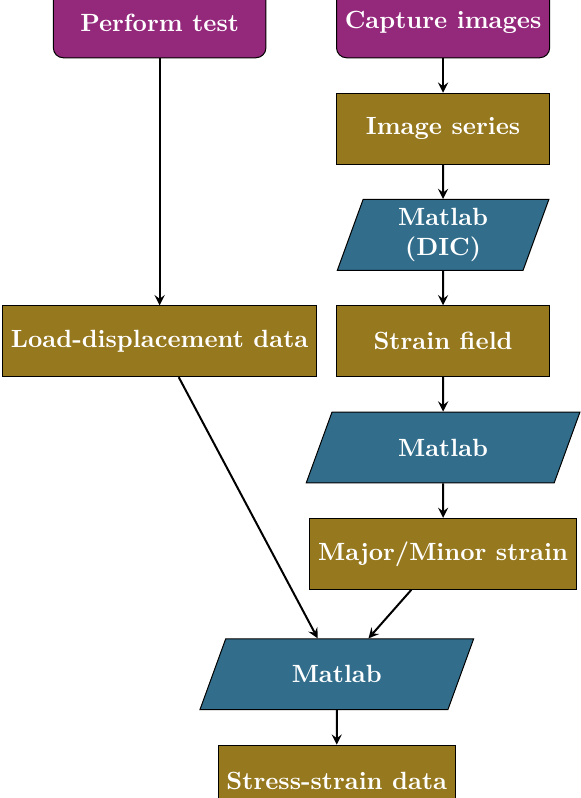
Figure 2. Digital image correlation results at max strains in ε ε Major (D), ε Minor (E) and ε Minor /ε Major (F).